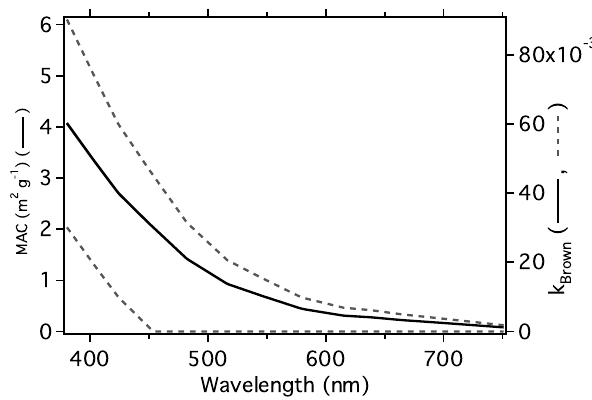
Fig. 2. Wavelength dependent mass absorption cross-section (MAC) of C Brown with a form as given by Sun et al. (2007) and where the absolute magnitude of the k Brown (solid black line) has been deduced from Barnard et al. (2008). Dashed lines indicate k Brown upper and lower bounds for our